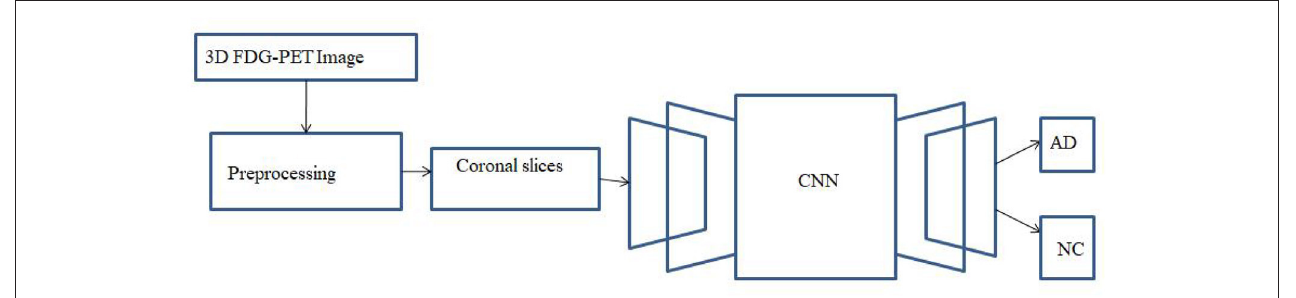
FIGURE 2 | Framework of the proposed CAD system.